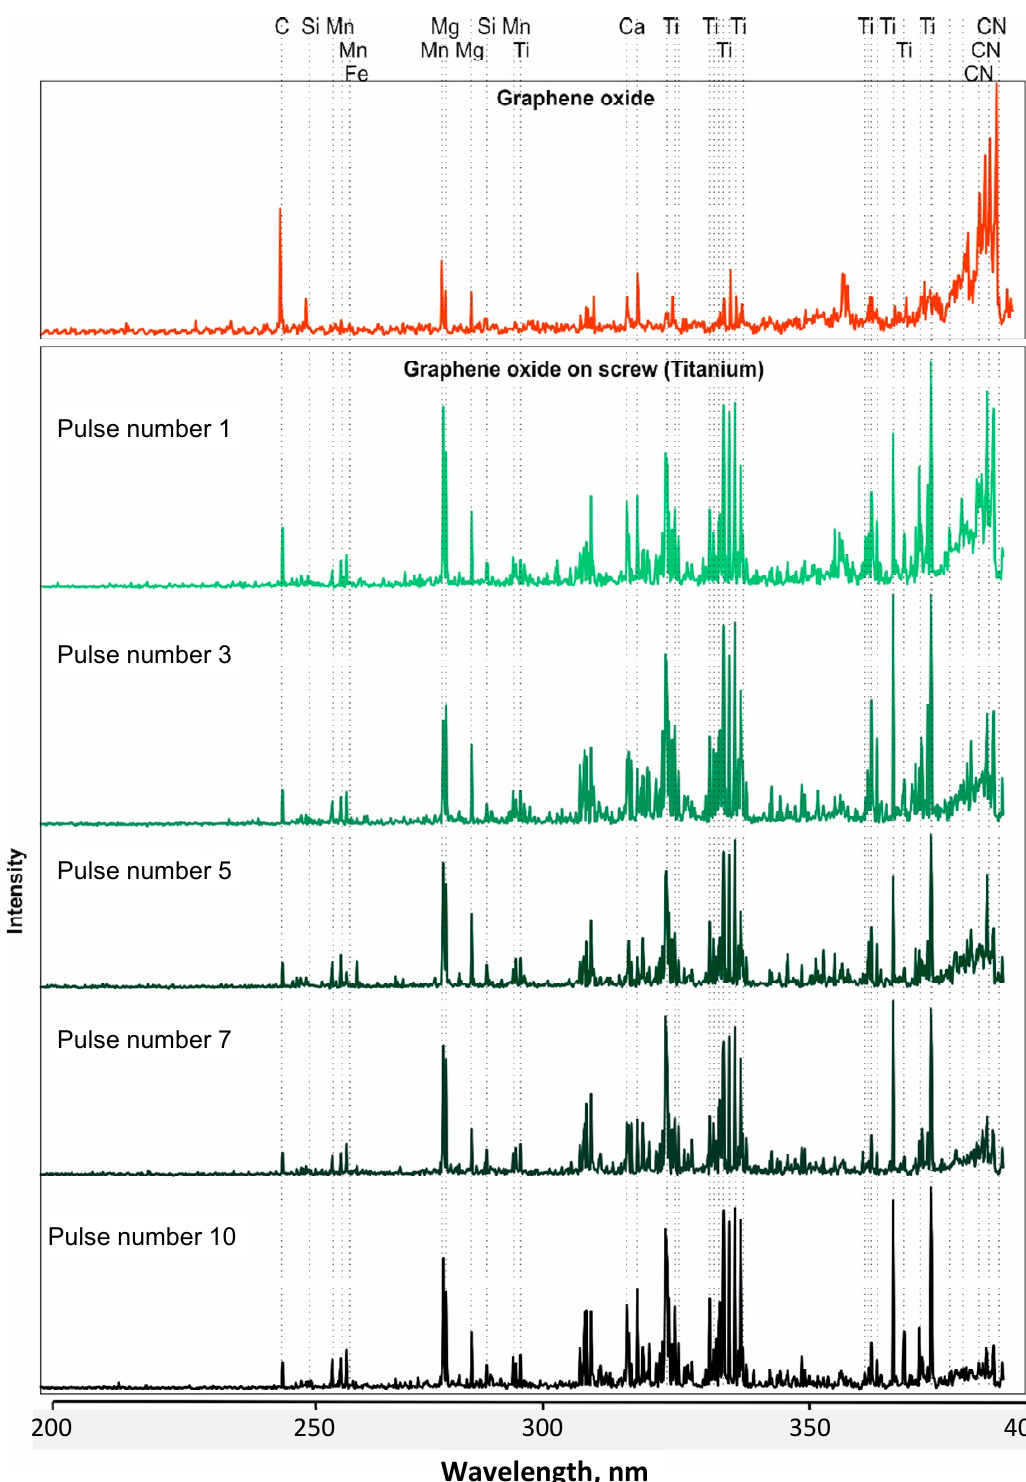
Figure 6. LIBS spectra of graphene oxide deposited on a thread in a titanium alloy Ti6Al4V, obtained with a di ff erent number of laser beam pulses and related to the spectrum of graphene oxide.